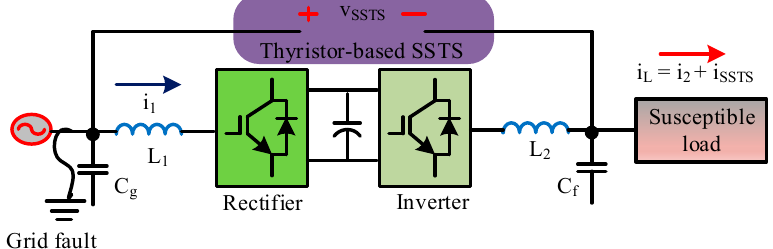
Figure 6. Forced commutation topology of thyristor-based SSTS [3].